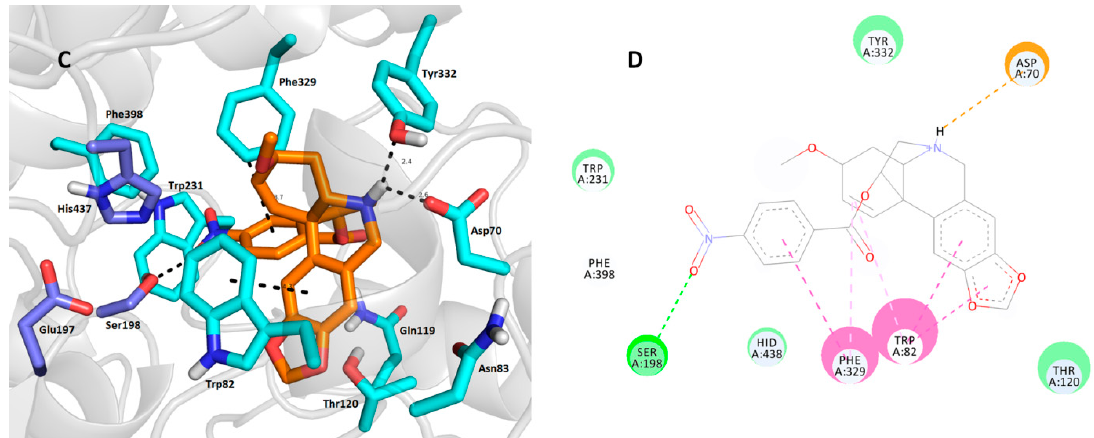
Figure 4. Docking poses of compounds 1j ( A , B ) and 1m ( C , D ) in the h BuChE active site (PDB ID: 4BDS) [45]. Close-up view for each ligand is presented as three-dimensional ( A , C ) and two-dimensional ( B , D ) diagrams, respectively. In A and C — 1m and 1j are presented in orange, important amino acid residues in light blue and the catalytic triad in dark blue. Dashed lines in all figure parts represent crucial intermolecular interactions of different origin (hydrogen bonds–orange lines, π - π / π -cation stacking–pink/purple lines, van der Waal’s interactions and other hydrophobic forces–green lines). Figures A and C were created with The PyMOL Molecular Graphics System, Version 2.0